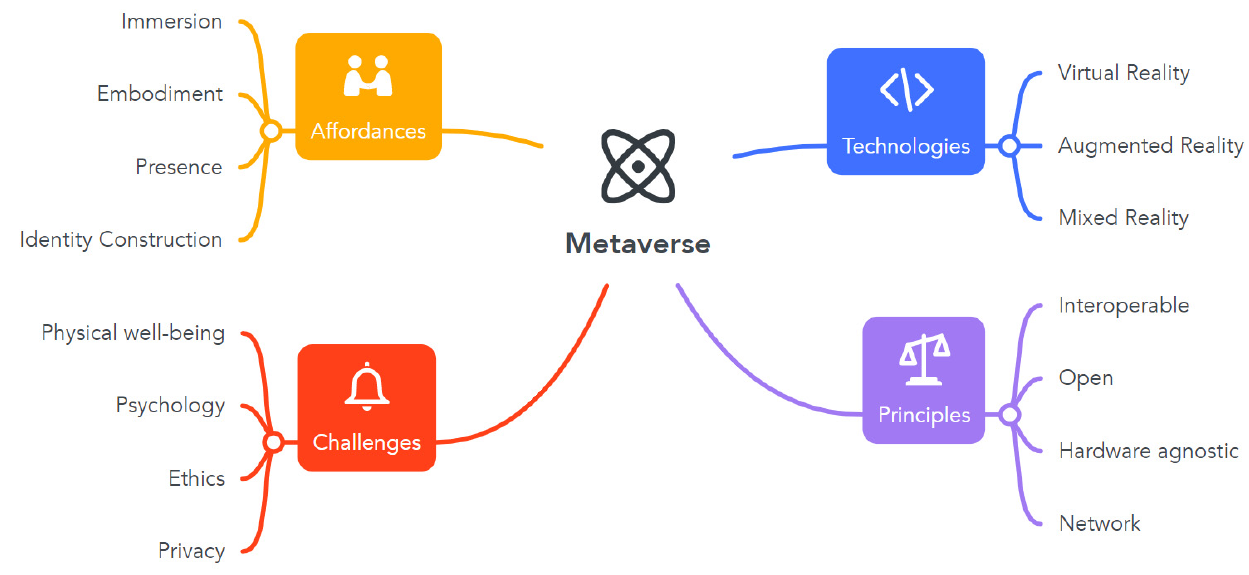
Figure 1. Metaverse technologies, principles, affordances and challenges.